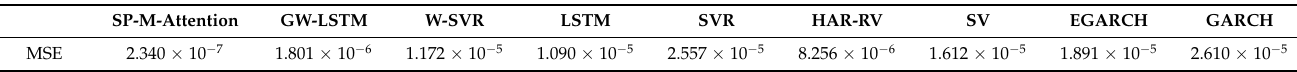
Table 5. Comparison of MSE of SP-M-Attention with other baseline models for the multivariate volatility forecasting task. SP-M-Attention